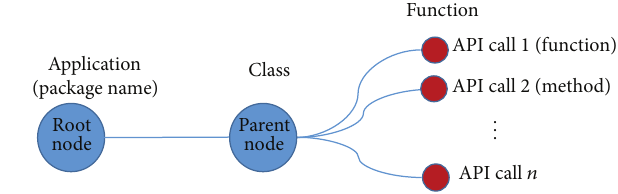
Figure 3: Schema used for the